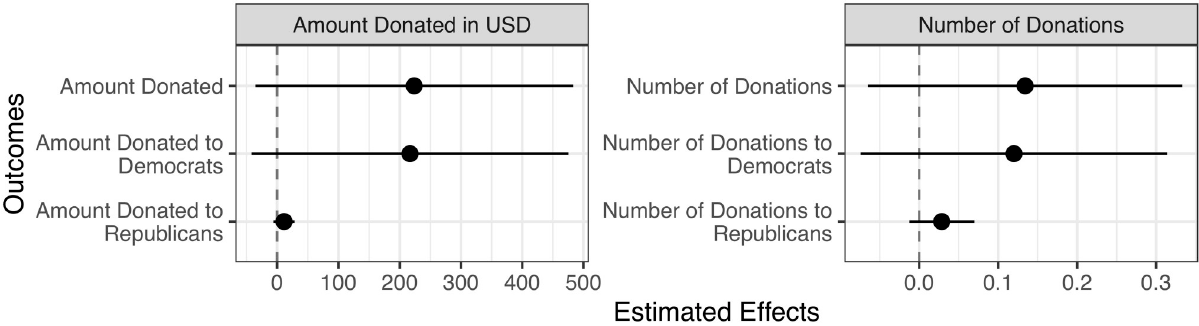
Fig 4. Effect of being awarded the NSF graduate research fellowship on political donations. N = 2, 119. The error bars represent 95% confidence intervals calculated from the heteroscedasticity-consistent standard errors. S1 Data of S3 Table contains the effect estimates, standard errors, two-sided p -values, and baseline